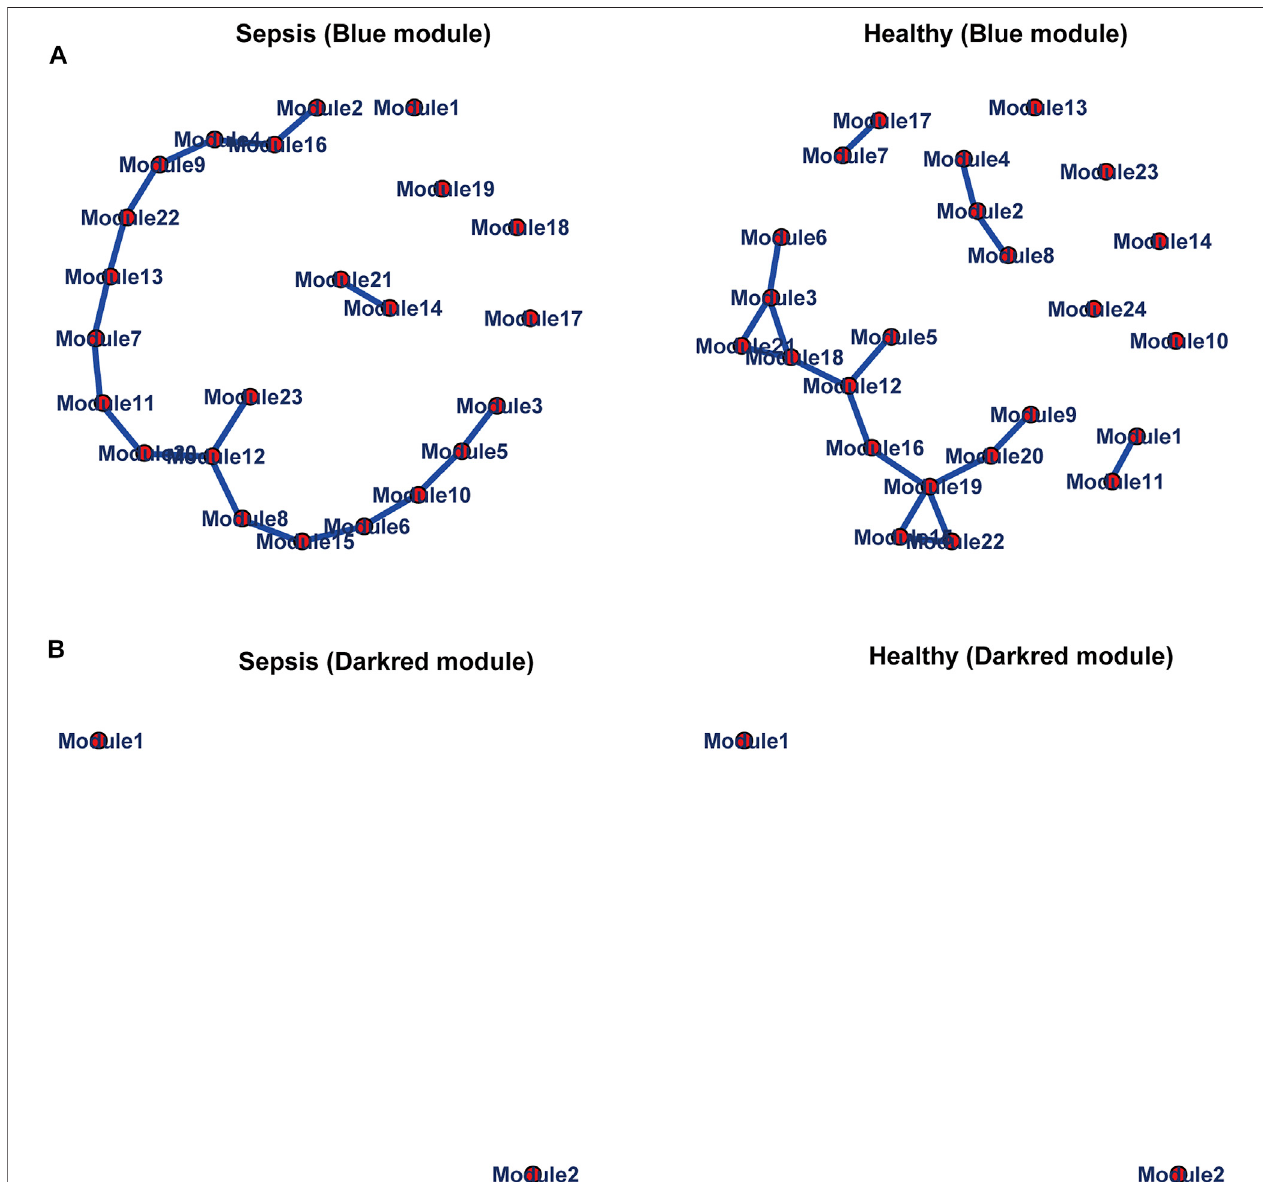
FIGURE 4 | Module networks. The blue (A) and darkred (B) module networks from GSE134347 were shown. Each node represented one module. Each edge represented module correlation.